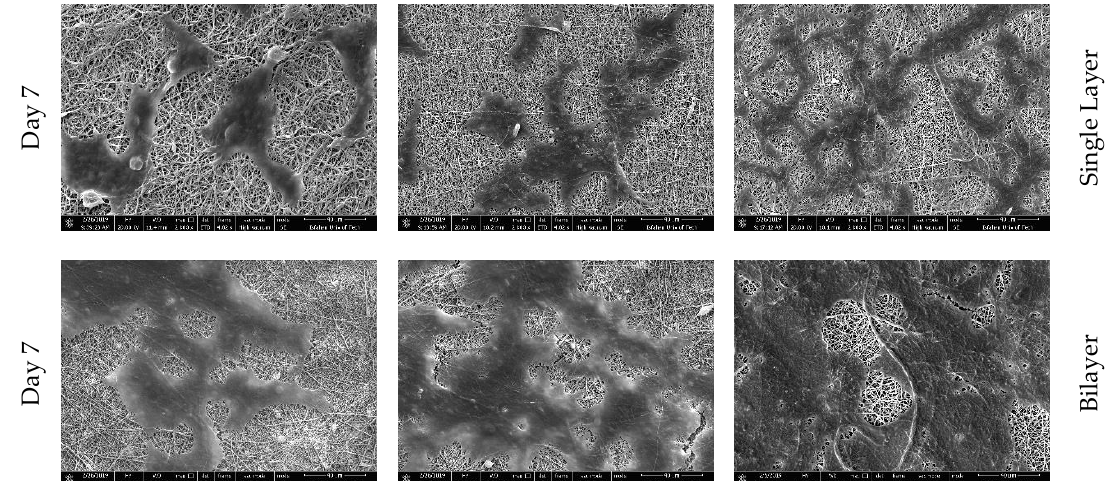
Figure 7. Morphology of the MG-63 cells on PCL/Ge/forsterite nanofibers with 1 and 3 wt.% and GO-PCL/Ge/forsterite with 1 and 3 wt.% after one and seven days of cell culture.